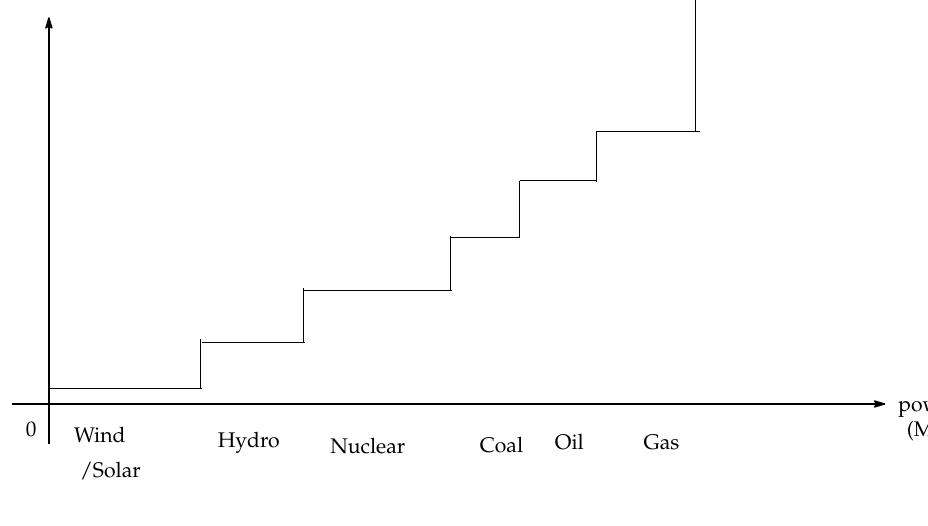
Figure 1. Merit order